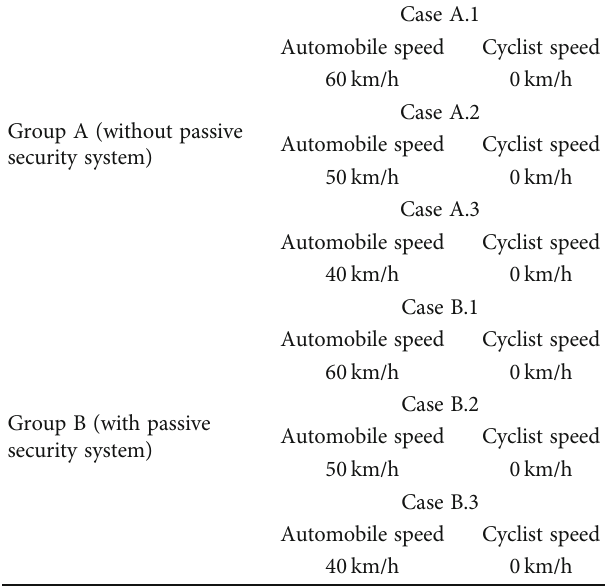
Table 1: Characteristics of run-over